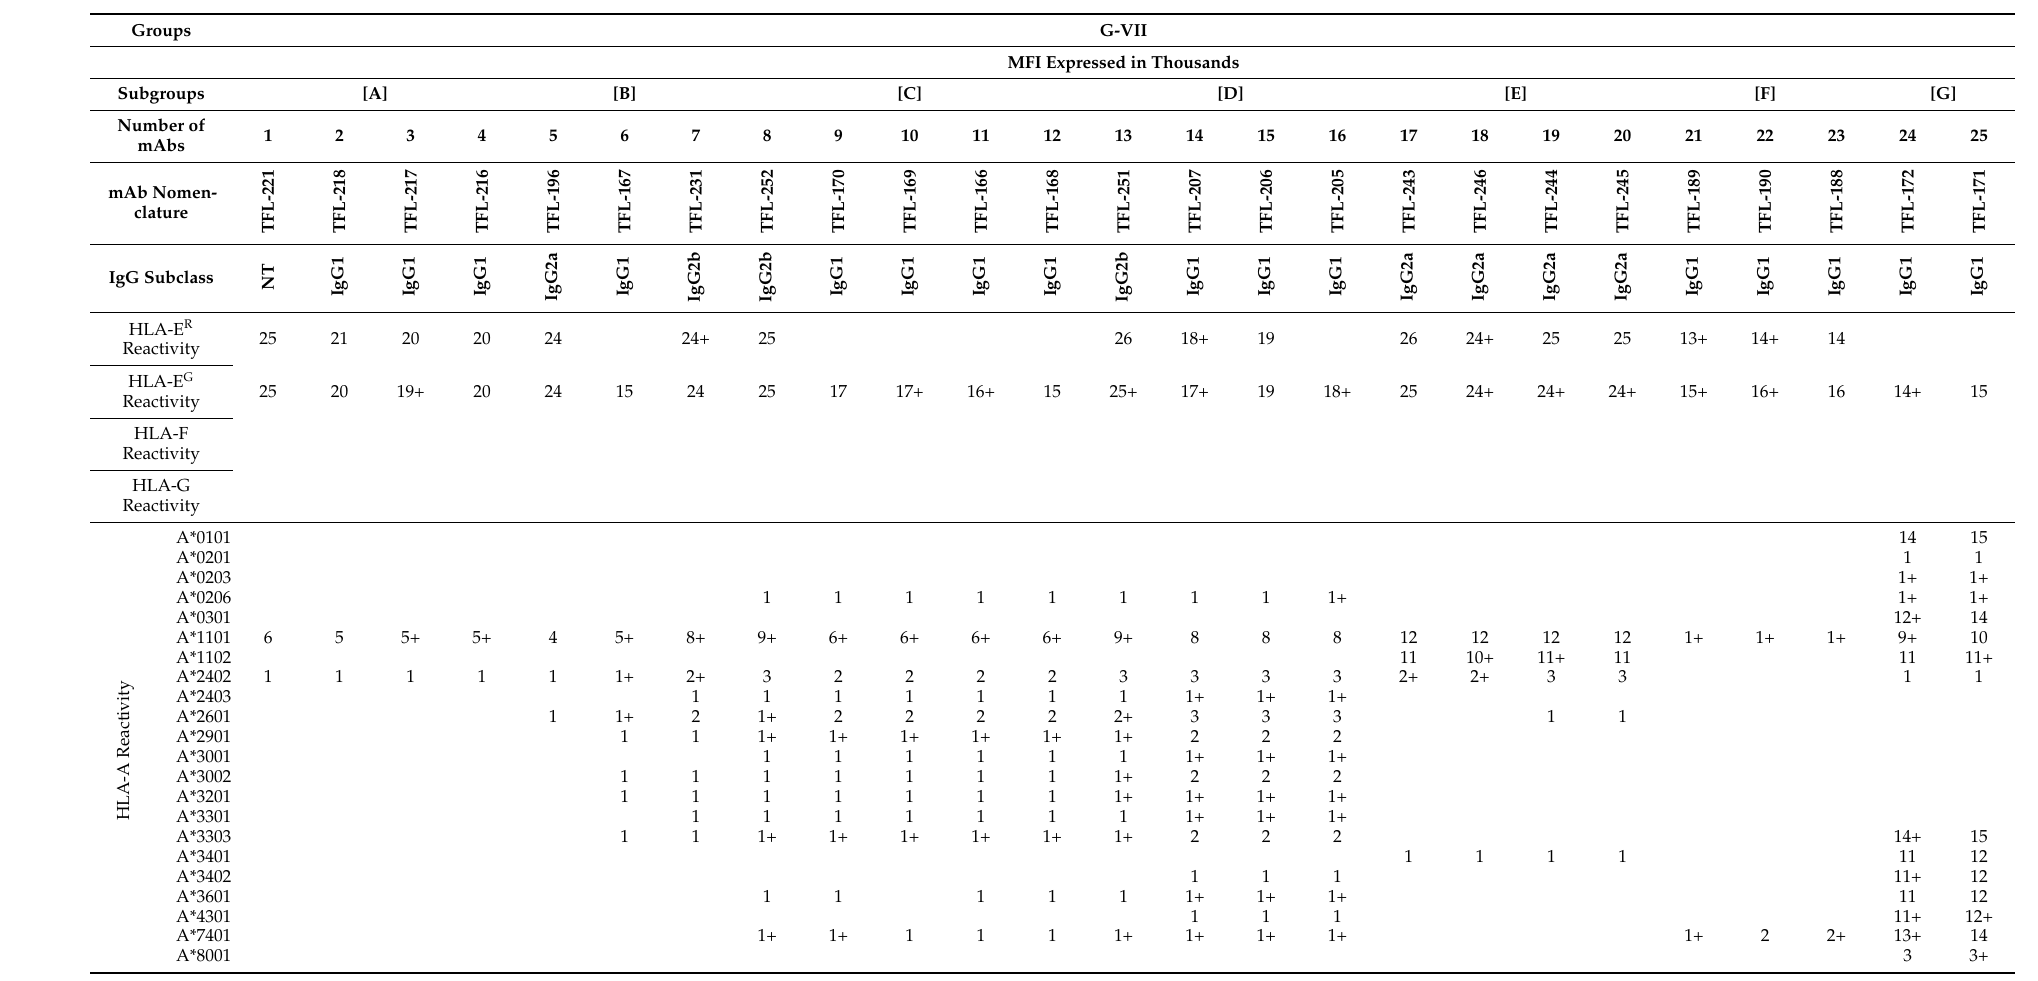
Table 8. Evolving HLA-E G mAbs: HLA-F and HLA-G non-reactive but reactive to HLA-A, HLA-B, and HLA-C